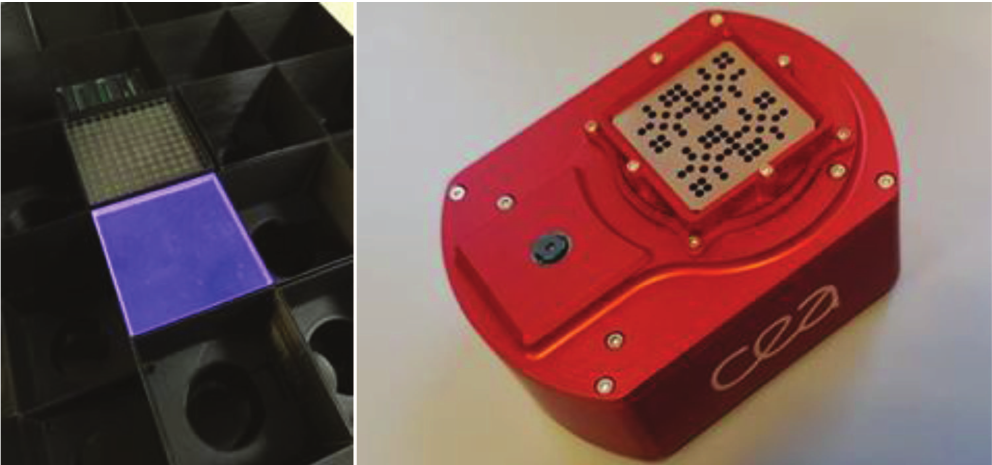
Fig. 9. Contamination Monitoring System and Nanopix gamma imager with spectrometric abilities developed by CEA to be implemented in the CLEANDEM robotic